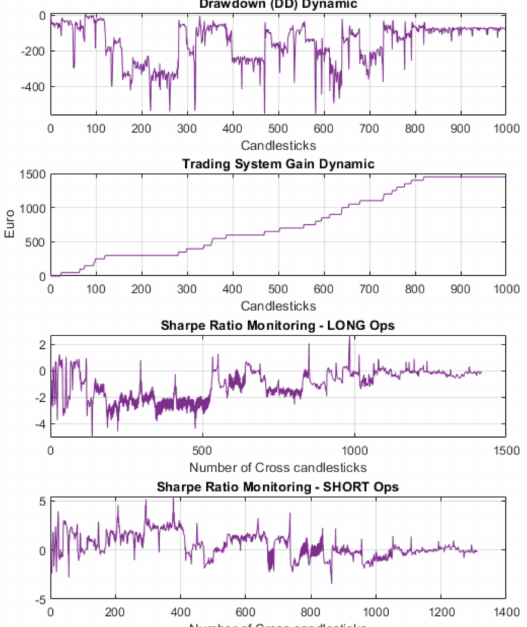
Figure 10. GUI interface of the proposed trading system